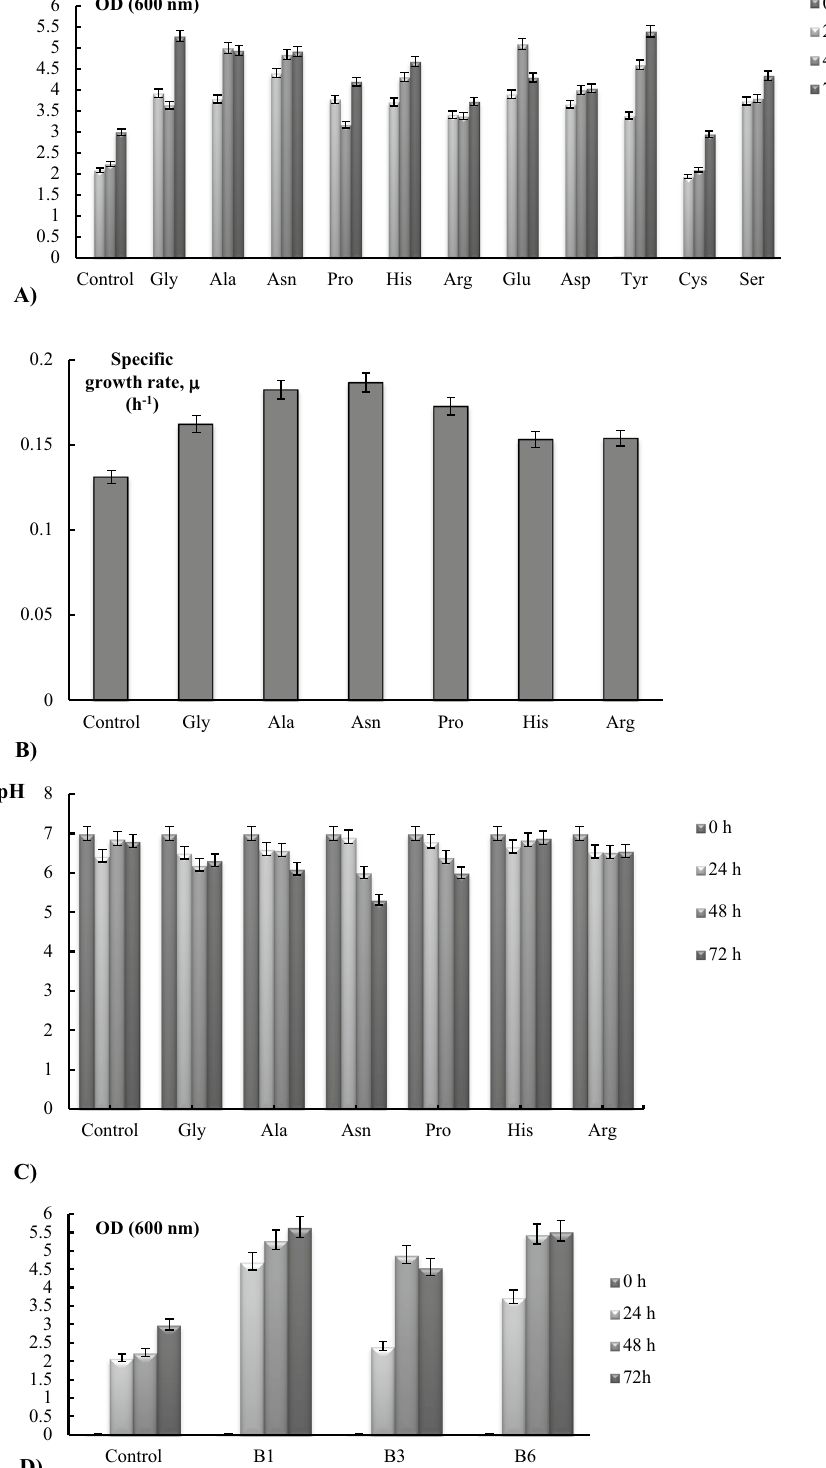
Fig. 4 R. eutropha H16 growth in the presence of l -Amino acids (AAs). Bacteria were grown aerobically, at pH 7.0, for 72 h: Kinetic of a OD (600 nm) with the addition of L-AAs; b specific growth rate, μ (h − 1 ) and c pH; d bacterial growth (OD) with the addition of vitamins; n is FN (without AAs addition), L-AAs and vitamins were added in FN medium at 7.0 μmol/ml concentration. The average data of 4 independent measurements are presented with standard